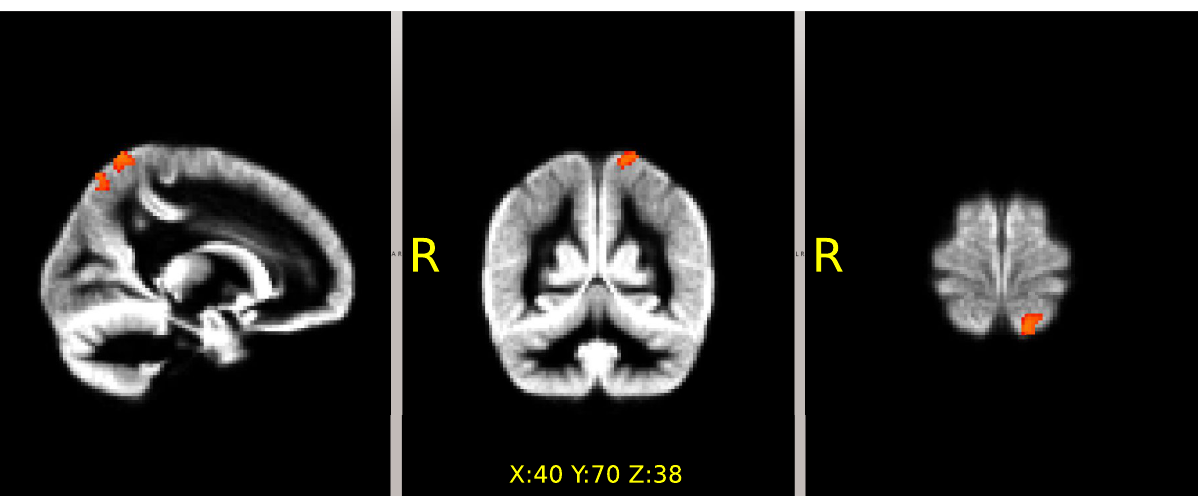
Fig 2. Focal decrease of the gray matter density in the Parkinson’s patients revealed by voxel-based-morphometry. The localization was the same in the comparisons with (flipped to the left side: p < 0.014 and to the right: p < 0.02, corrected) and without flipping (p < 0.059). MNI coordinates of the voxel showing the highest significance is provided on the